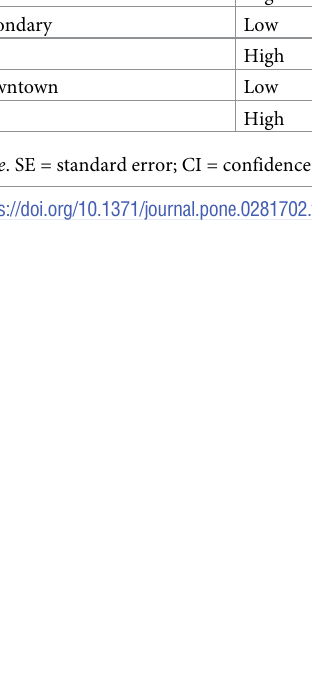
Table 8. Participants’ reported manual driving speed (in km/h) according to type of road × traffic congestion level. Type of road